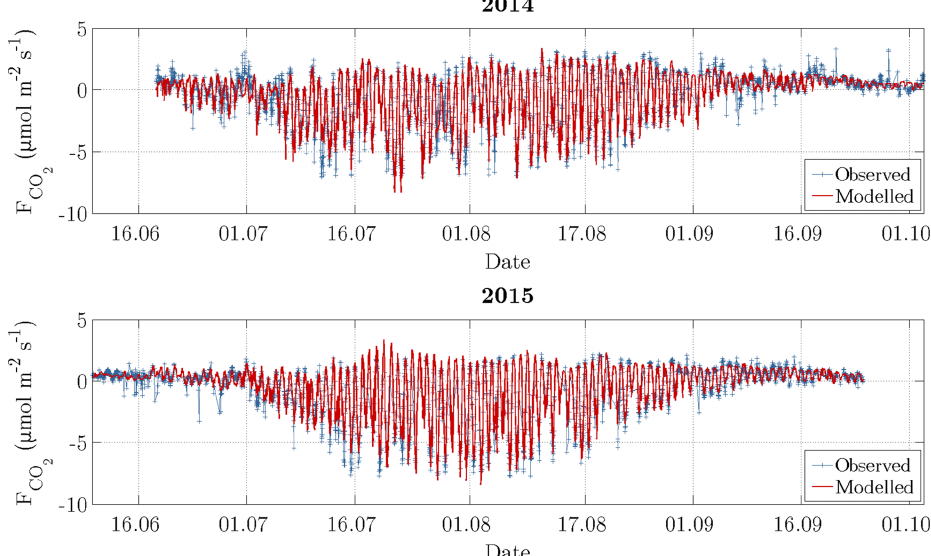
Figure 5. Time series of observed carbon dioxide fluxes (after conducting the quality assessment) and modelled fluxes. During the growing season, which is indicated by an elevated variability between late June and early September, the daytime uptake directly followed the diurnal cycle of PPFD, while the nighttime release was dependent on air